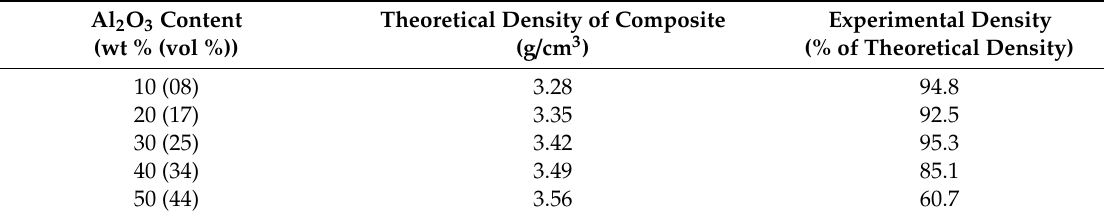
Figure 8. ( a ) Density and ( b ) hardness of sintered glass mixed with Al 2 O 3 as functions of Al 2 O 3 content. Table 2. Theoretical and experimental densities of composites. Table 2. Theoretical and experimental densities of composites.